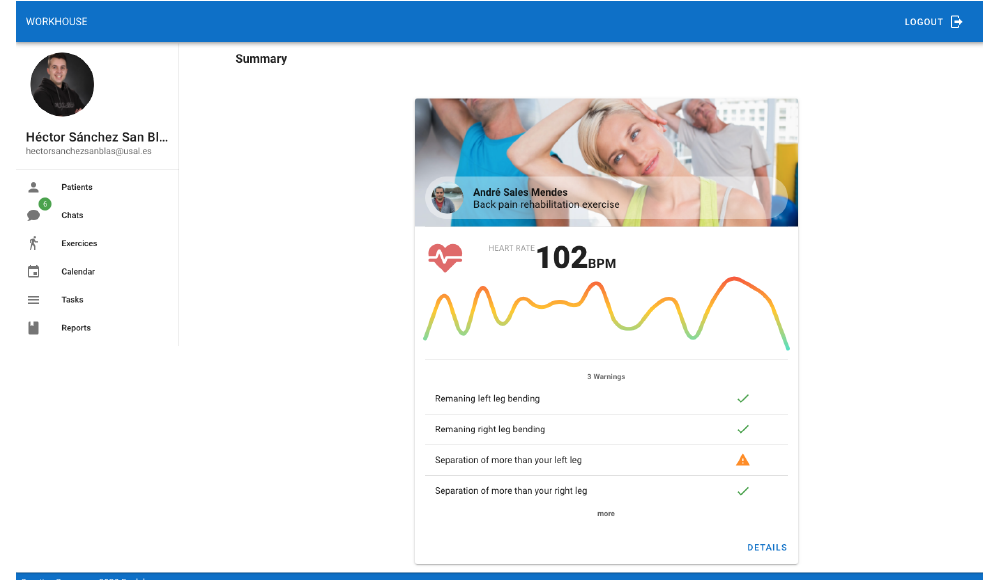
Figure 8. Monitoring interface.